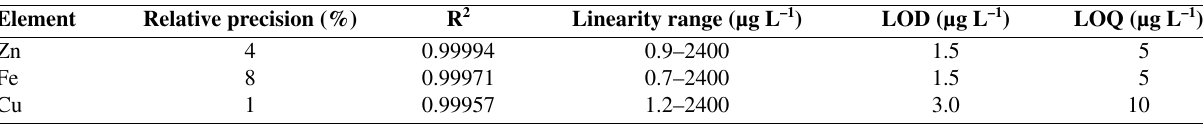
Table 2 . Analytical method